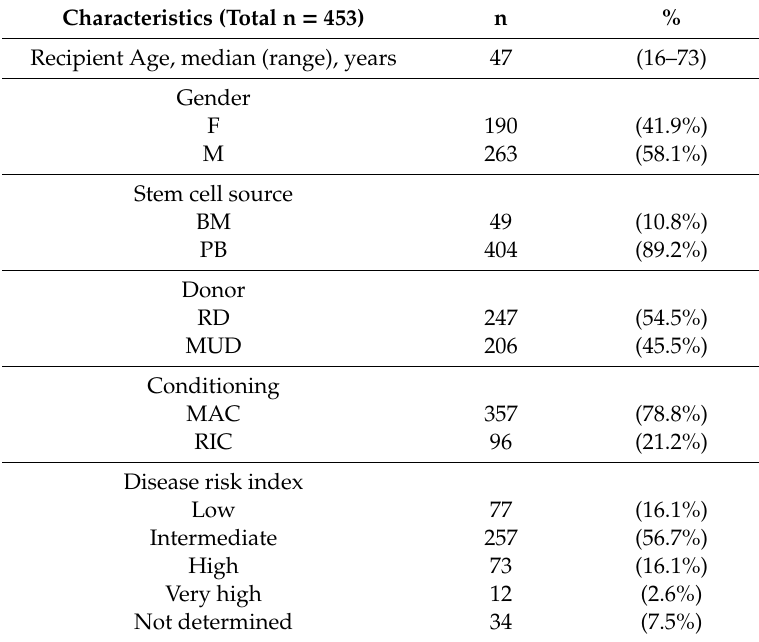
Table 2. Characteristics of the patients with paired samples included in this